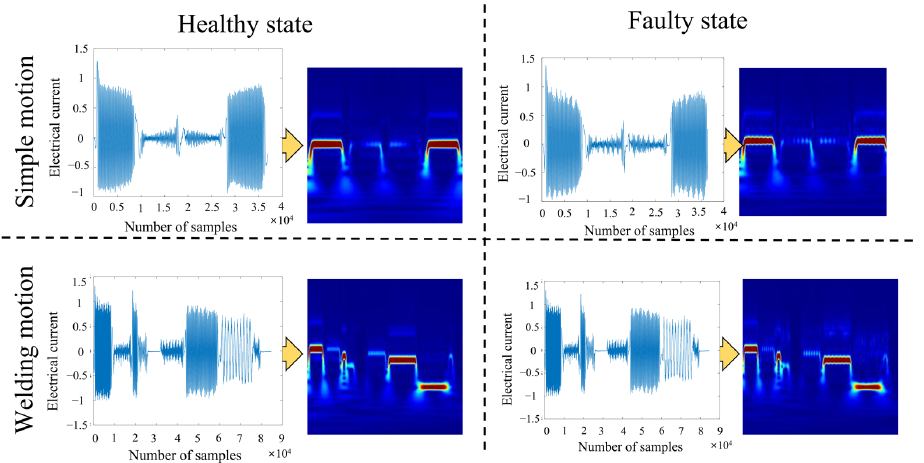
Figure 5. Scalogram representation of simple and welding motion for healthy and faulty states.